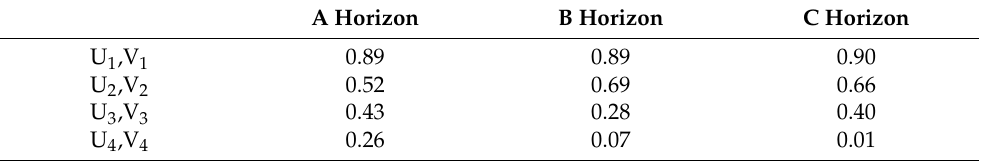
Table 5. Correlation coefficients between canonical variables U and V calculated for each soil horizon.